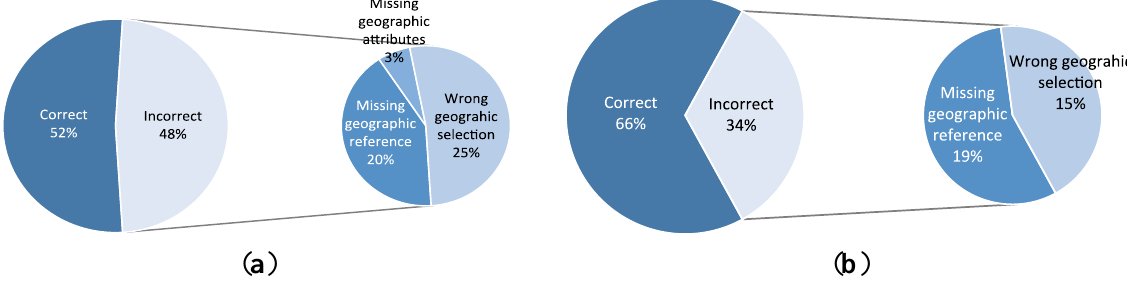
Figure 7. Main causes of incorrect descriptions (( a ) average and ( b ) best geographic